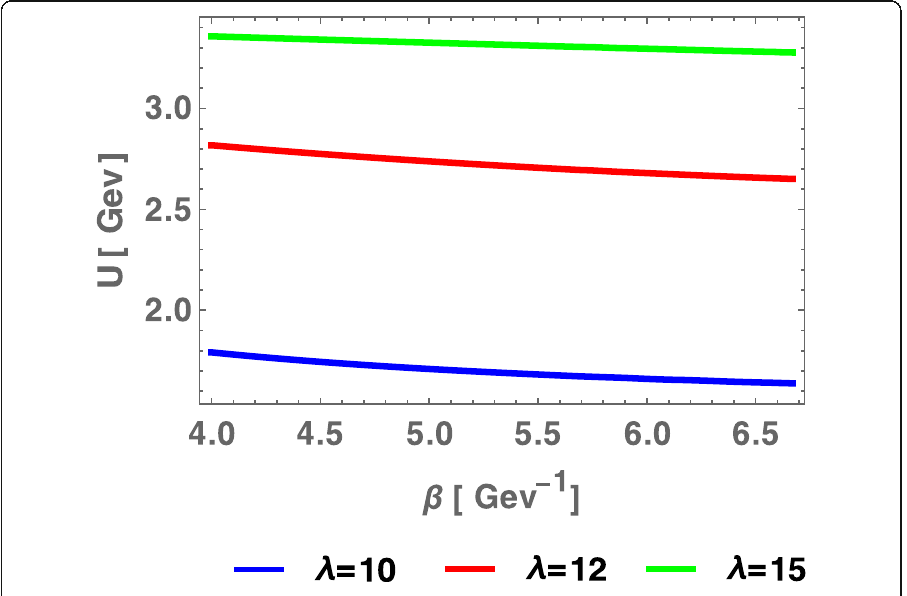
Fig. 3 Internal energy U against β for different values of